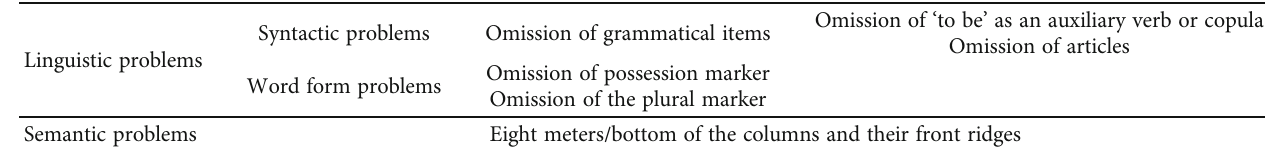
Table 2: Linguistic and semantic problems of English translation of mosque ’ s yard brochure.